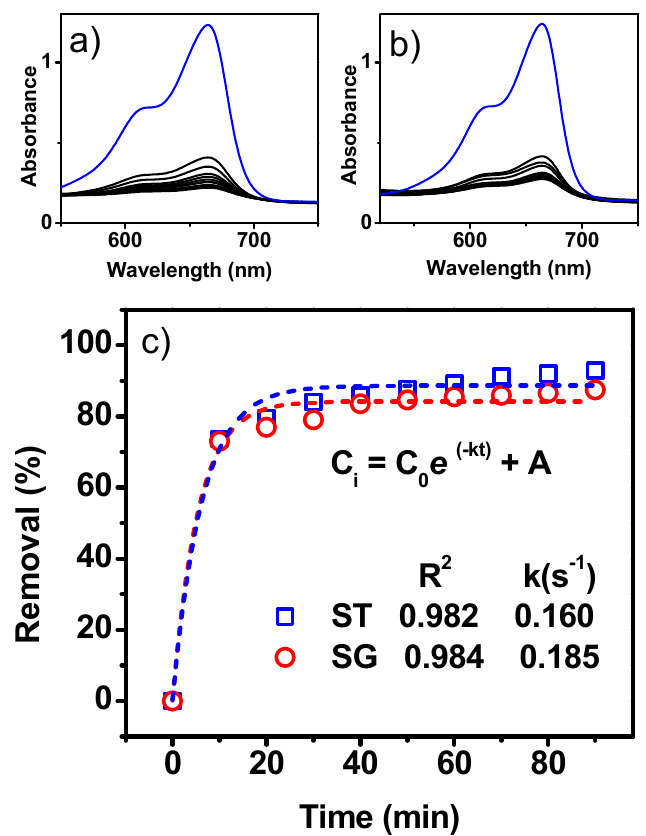
Figure 6. Evaluation of mechanical processes applied to Sargassum spp. in methylene blue removal: ( a , b ) UV-Vis spectra using crushed (ST) and ground (SG) CT- Sargassum spp., respectively. ( c ) Removal curves for each condition.